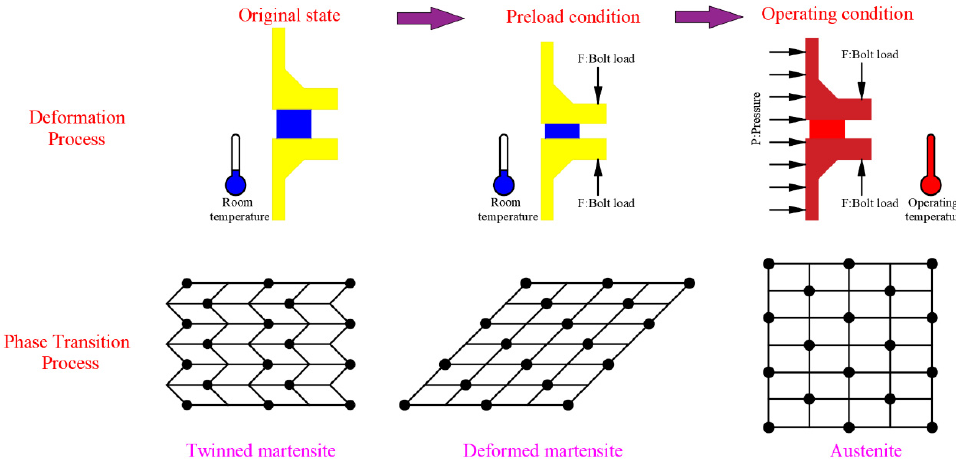
Figure 1. Deformation and phase transition process of NiTi alloy gasket.